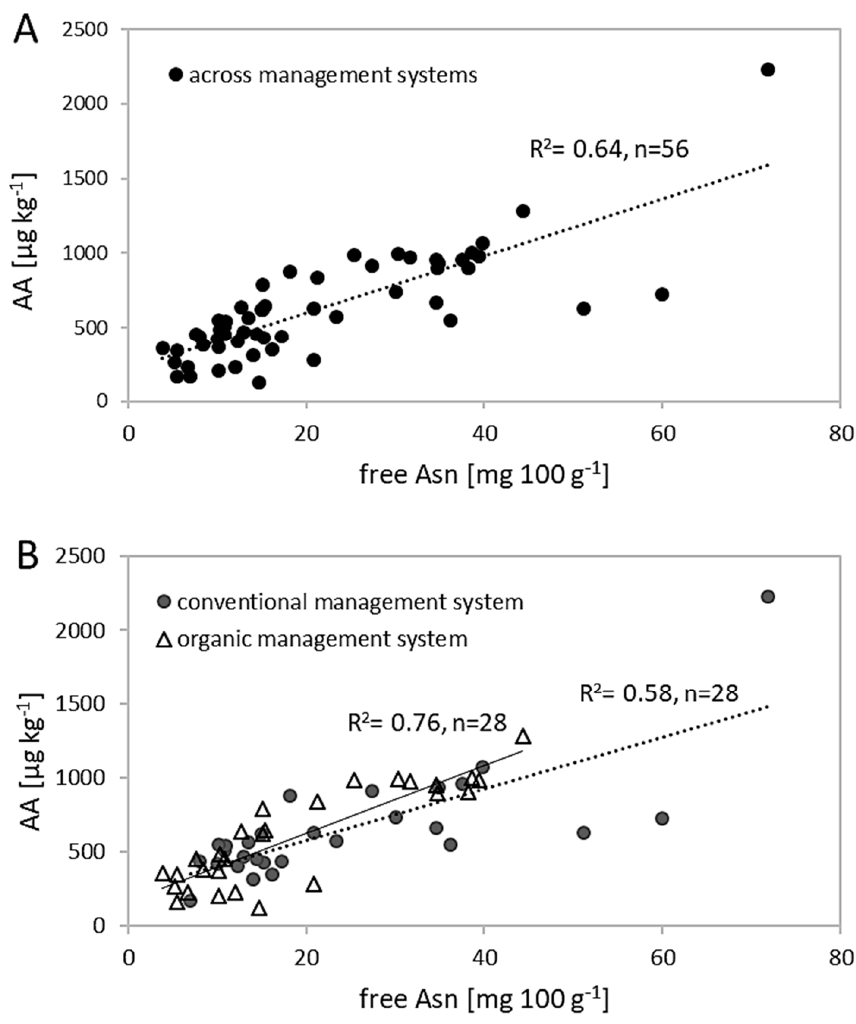
Figure 3. Relationship between free Asn in wheat flours and AA in heated wheat flours across management systems ( A ) and separated by conventional vs. organic management system ( B ).